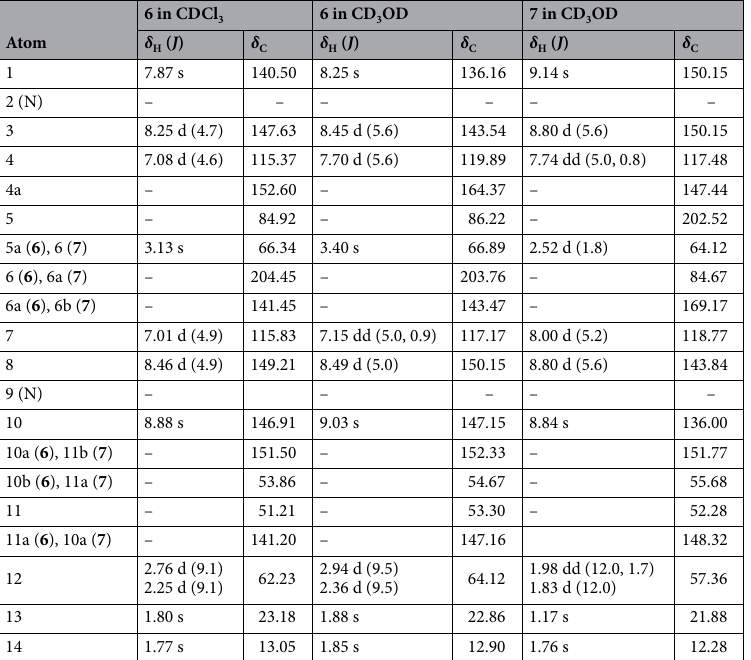
Table 3. 1 H and 13 C NMR data of compound 6 in CDCl 3 and in CD 3 OD and of compound 7 in CD 3 OD ( δ in ppm, J in